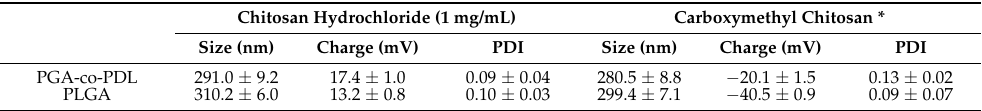
Figure 2. Effect of chitosan hydrochloride or carboxymethyl chitosan addition on particle size, poly dispersity index (PDI) and zeta-potential of hybrid NPs prepared by o / w single emulsion method. ( a ) particle size, ( b ) PDI, and ( c ) zeta-potential of PGA-co-PDL and PLGA hybrid nanoparticles. Data represent mean ± SD, n = 3. Table 3. Effect of chitosan hydrochloride or carboxymethyl chitosan addition on particle size, zeta- potential, and poly dispersity index (PDI) of hybrid NPs formulated by the w / o / w double emulsion method (mean ± SD, n = 3).